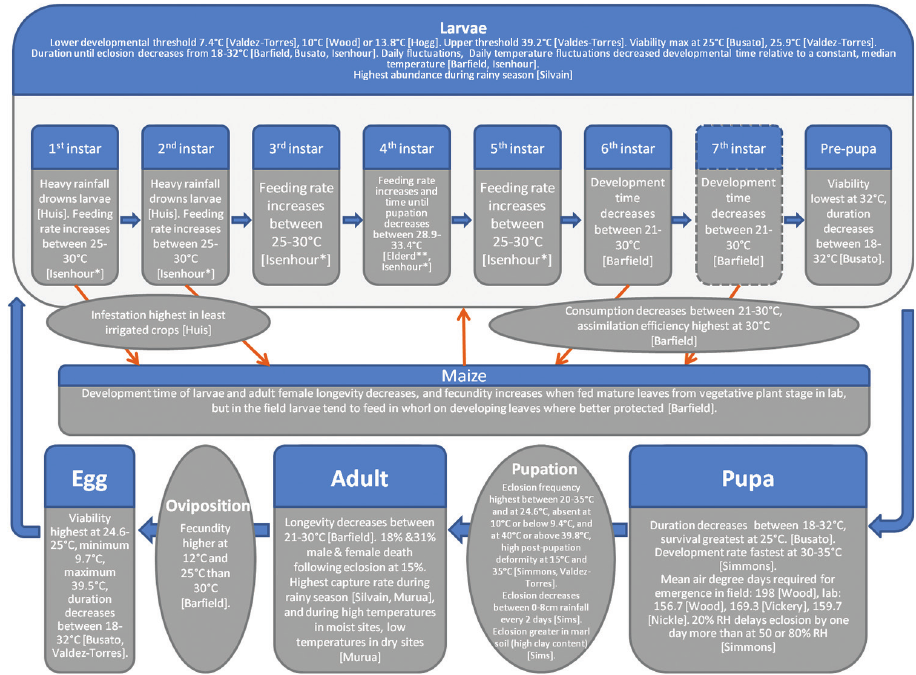
Figure 2. Empirically measured environmental effects on fall armyworm life cycle. Summary of data from literature of temperature, moisture, soil and host plant effects on fall armyworm survival and devel- opmental time and observations of abundances in the field under different conditions and seasons. All studies were conducted with populations from the Americas. Rectangles are life stages, ovals are processes. Orange arrows represent effects of fall armyworm on maize or vice versa. The occurrence of a 7 th instar is not universally reported. Only direct effects (measured or imputed) of the environment and host on fall armyworm were included. Unless otherwise noted, moths for experiments were reared on fresh maize or an artificial diet. RH is relative humidity. More information is given in Suppl. material 1: Table S1, Figure